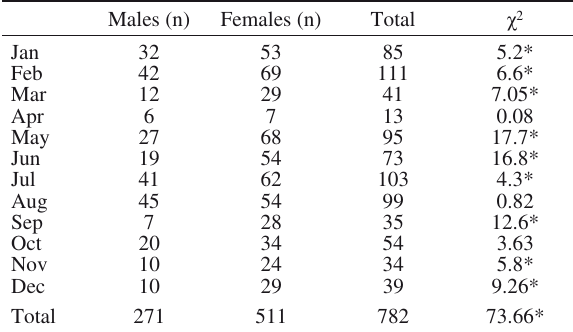
Table 2. – Sex ratio of males and females of dolphinfish, Cory- phaena hippurus , and results of the chi-square ( χ 2 ).* Statistical dif- ference level of significance 5%